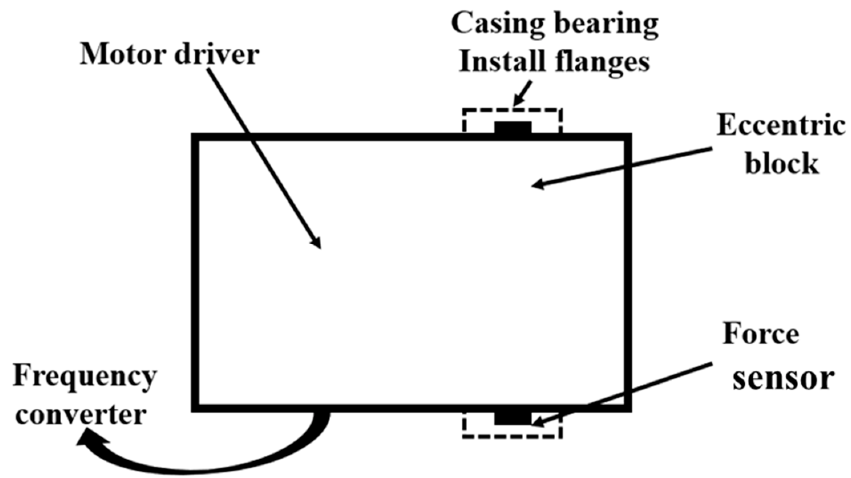
Figure 1. Three-dimensional model diagram of the whole casing for aero engine.